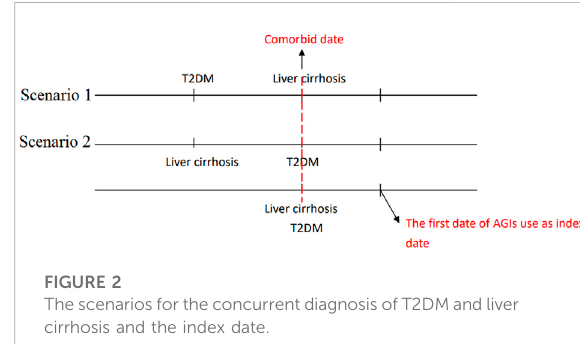
FIGURE 2 The scenarios for the concurrent diagnosis of T2DM and liver cirrhosis and the index date.